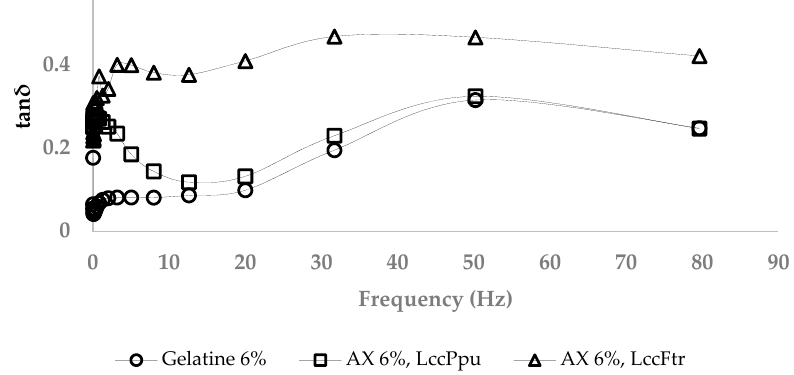
Figure 5. Comparing loss factors of AX (6%) and gelatin gels (6%).